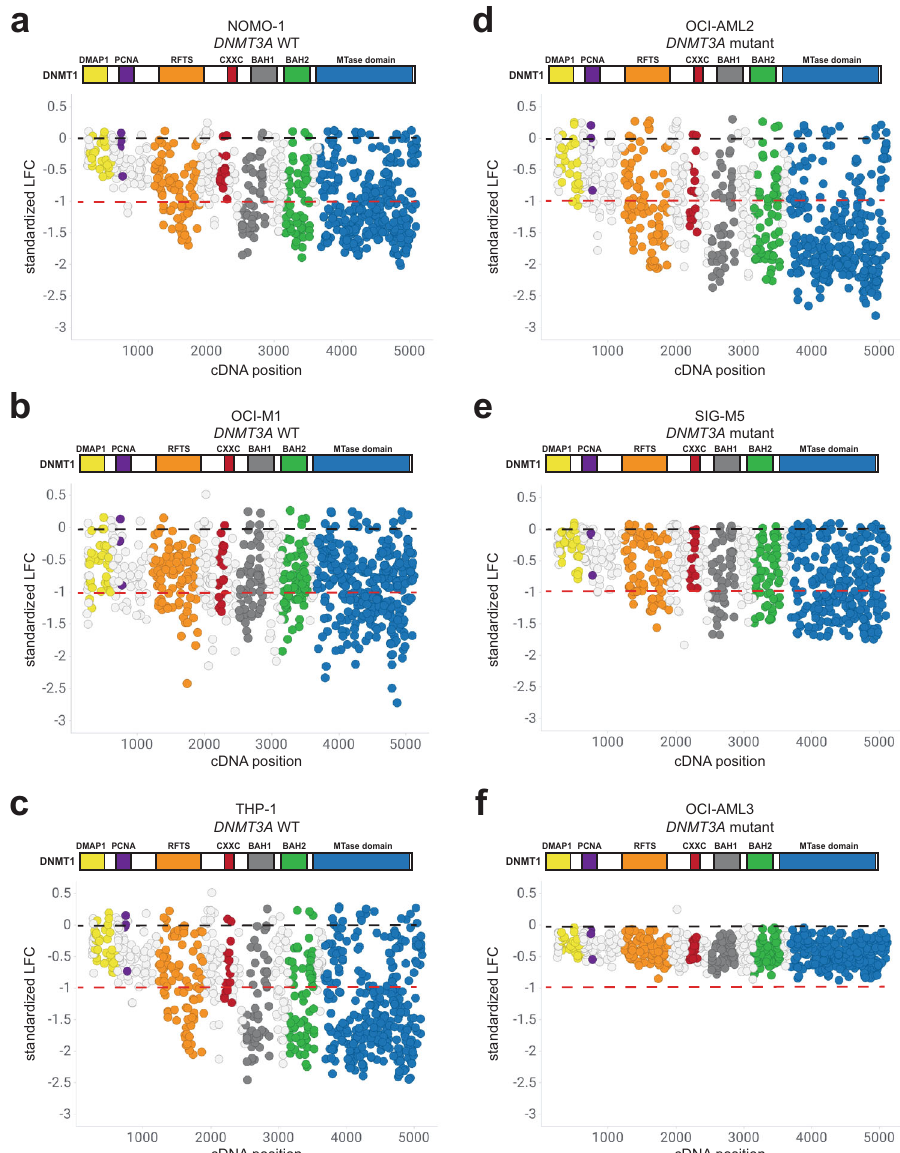
Fig. 4 Knockout mutations tiling the DNMT1 protein result in proliferative disadvantages across AML cell lines wild-type and mutant for DNMT3A . a – c sgRNAs tiling DNMT1 in AML cell lines wild-type for DNMT3A , NOMO-1 ( a ), OCI-M1 ( b ), and THP-1 ( c ) are shown with respect to their cDNA position along the coding region of DNMT1. d – f sgRNAs tiling DNMT1 in AML cell lines mutant for DNMT3A , OCI-AML2 ( d ), SIG-M5 ( e ), and OCI-AML3 ( f ), are shown with respect to their cDNA position along the coding region of DNMT1. Each circle represents an individual sgRNA targeting DNMT1 . The standardized LFC value for each sgRNA is plotted on each graph. The dashed black bar denotes the mean standardized LFC of the non-targeting controls for each cell line. The mean standardized LFC of the common essential sgRNAs is denoted by the red dashed line. The color of each circle represents the functional domain it targets: DMAP1 (yellow); PCNA (purple); RFTS (orange); CXXC (red); BAH1 (dark gray); BAH2 (green); MTase domain (blue). n = 3 replicates for each cell line ProTiler was run on individual sgRNAs spanning either DNMT1 (Fig. 5a) or DNMT3B (Fig. 5b) in AML cell lines wild-type for DNMT3A . Several CKHS regions were identi fi ed within the DNMT1 protein in NOMO-1 and THP-1 cells, spanning the RFTS, BAH1, BAH2, and MTase domains. One CKHS region within the MTase domain of DNMT1 was also identi fi ed in OCI- M1 cells (Fig. 5a). In contrast, very few consistent CKHS regions within DNMT3B were identi fi ed in any of the DNMT3A wildtype AML cell lines screened (Fig. 5b). ProTiler was next run on the AML cell lines mutant for DNMT3A . Several CKHS regions within DNMT1 were identi fi ed in the OCI-AML2 and OCI-